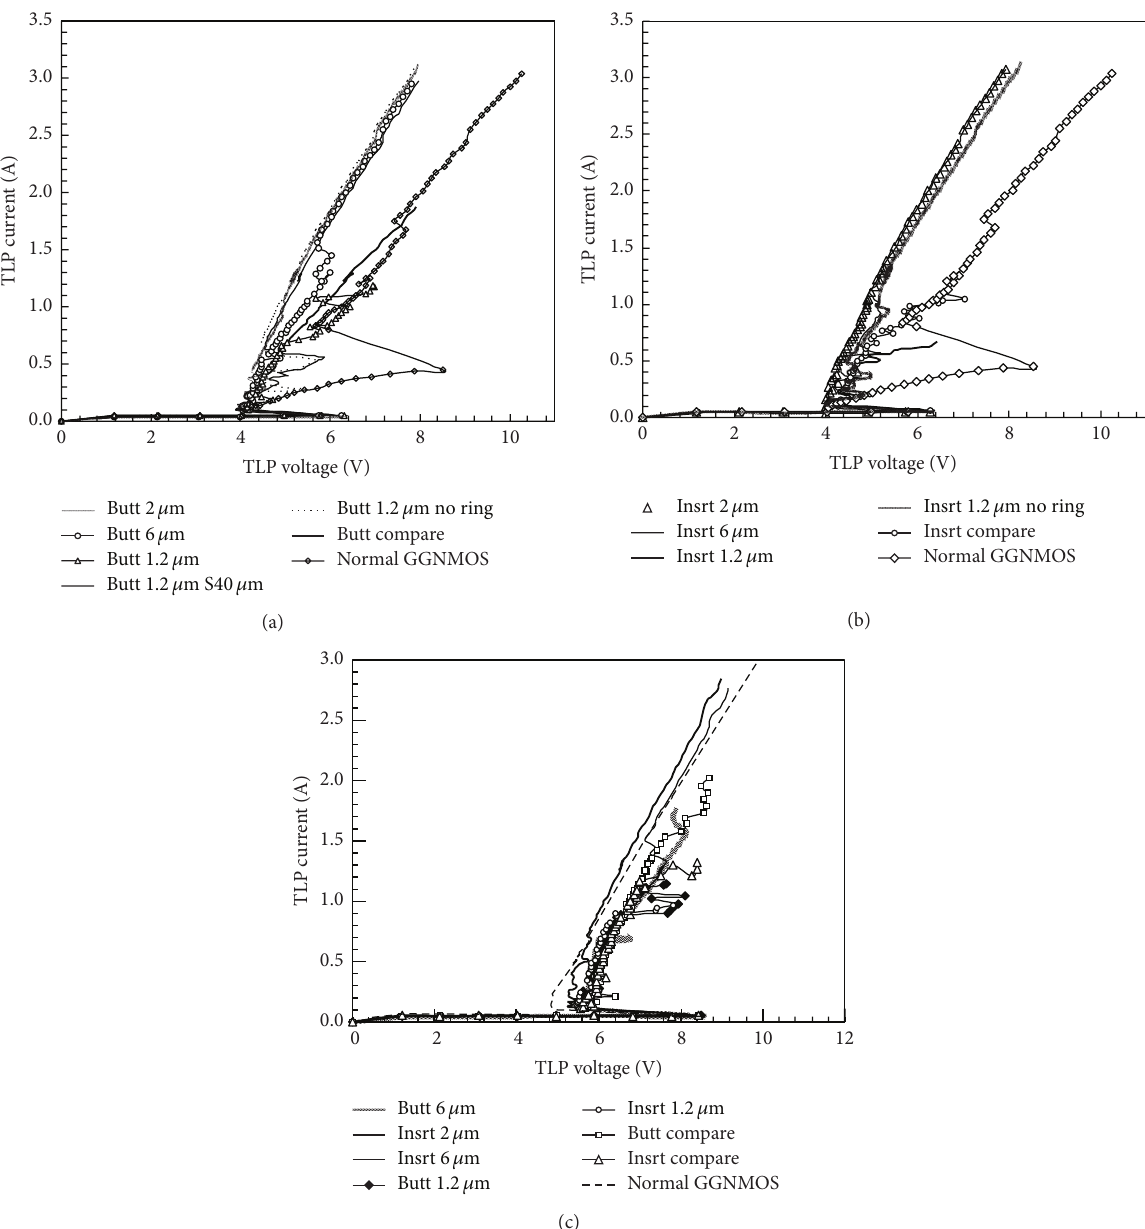
Figure 3: (a) TLP 𝐼 - 𝑉 curve comparison among the GGNMOS and various butting pickup conditions with 1.8 V power supply. (b) TLP 𝐼 - 𝑉 curve comparison among the GGNMOS and various inserted pickup conditions with 1.8V power supply. (c) TLP 𝐼 - 𝑉 curve comparison among the normal GGNMOS and various butting/inserted pickup conditions with 3.3 V power